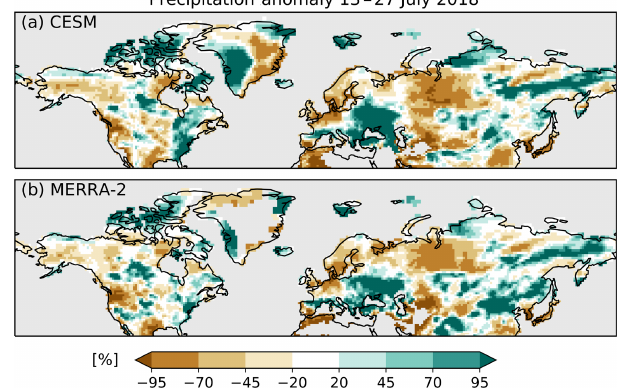
Figure 5. Precipitation anomaly (%) for 13 to 27 July 2018 com- pared to the 1981–2010 climatology. (a) CESM historical simula- tion (b) MERRA-2. Land areas with less than 0.1mmd − 1 precipi- tation in the climatology are masked